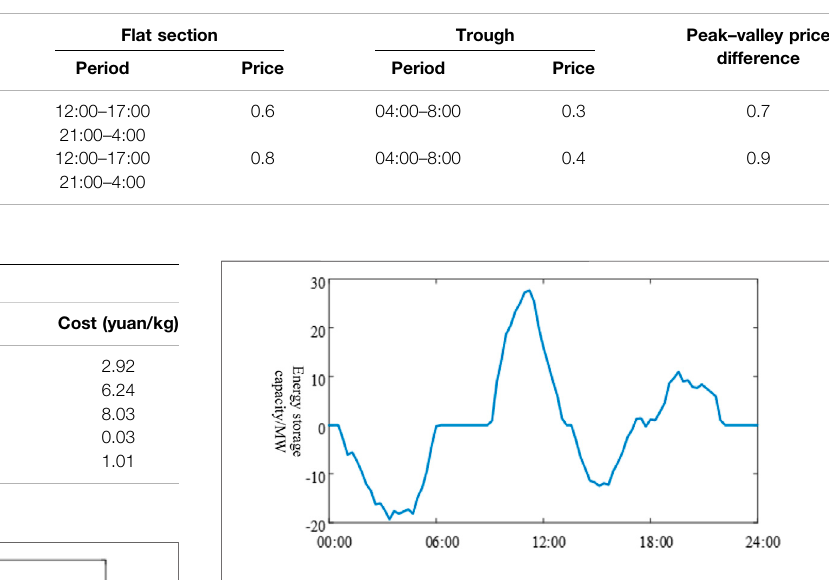
FIGURE 3 | Output curve of the decommissioned power